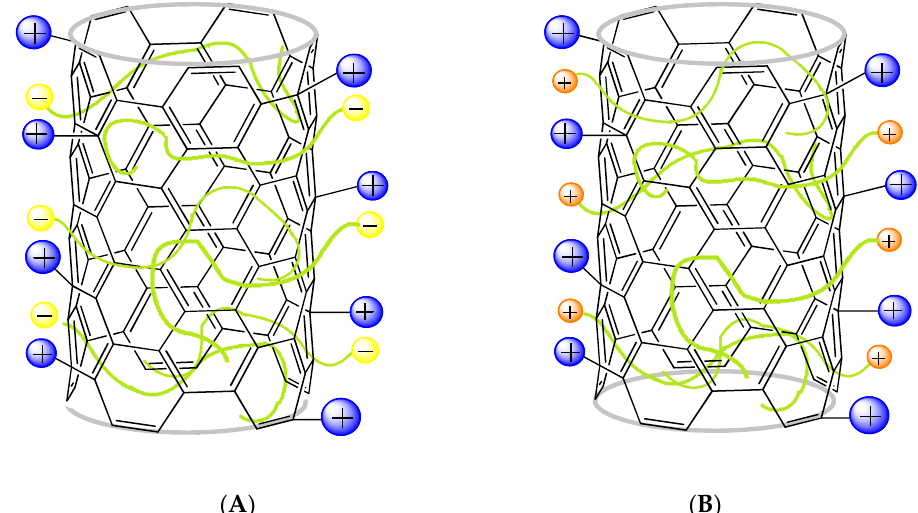
Figure 5. Schematic picture of the adsorption of anionic ( A ) and cationic ( B ) surfactants on the charged SWCNT-NH 2 surfaces (pH = 3).